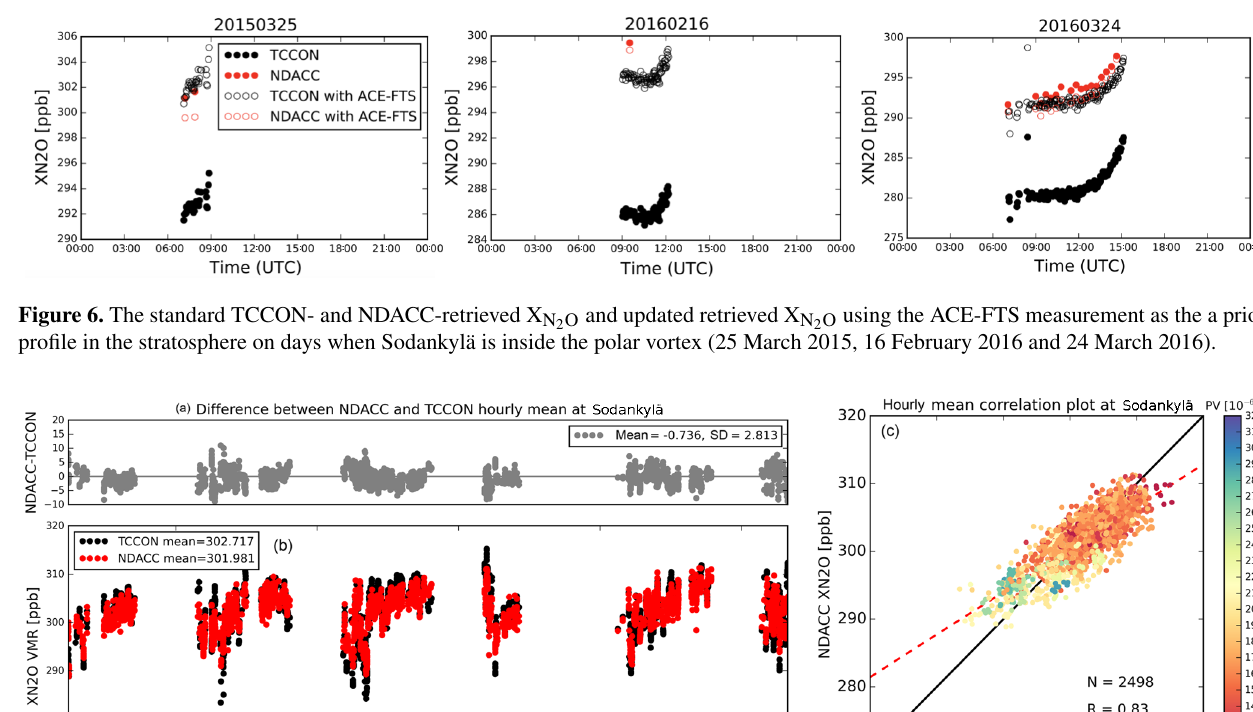
Figure 7. Same as Fig. 4, but showing the TCCON retrievals on the days inside the polar vortex (blue dots) using the ACE-FTS measurement as the a priori